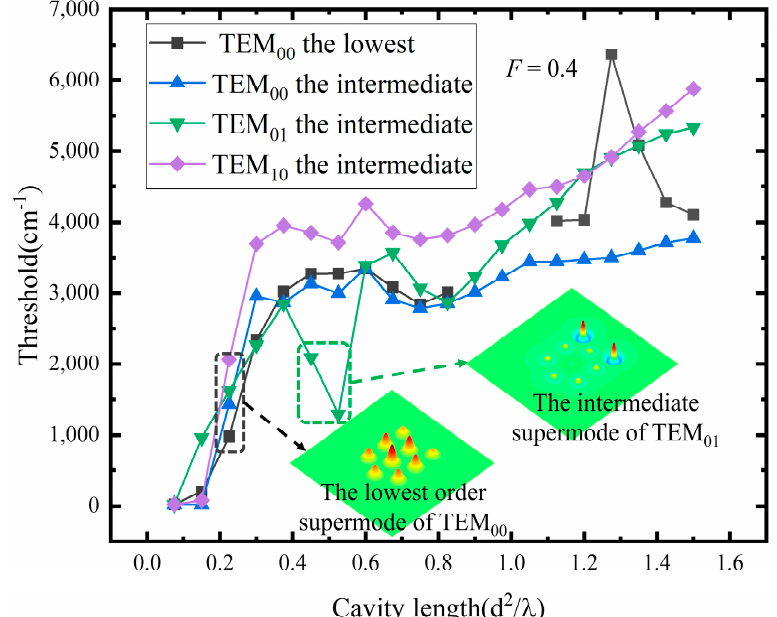
Figure 5. The thresholds of the lowest supermode and higher-order supermodes (the minimum values) with elements of TEM 00 , and the thresholds of supermodes with elements of TEM 01 and TEM 10 which are the regular hexagonal arrays versus the length of external cavity of 0.075 − 1.5 d 2 / λ